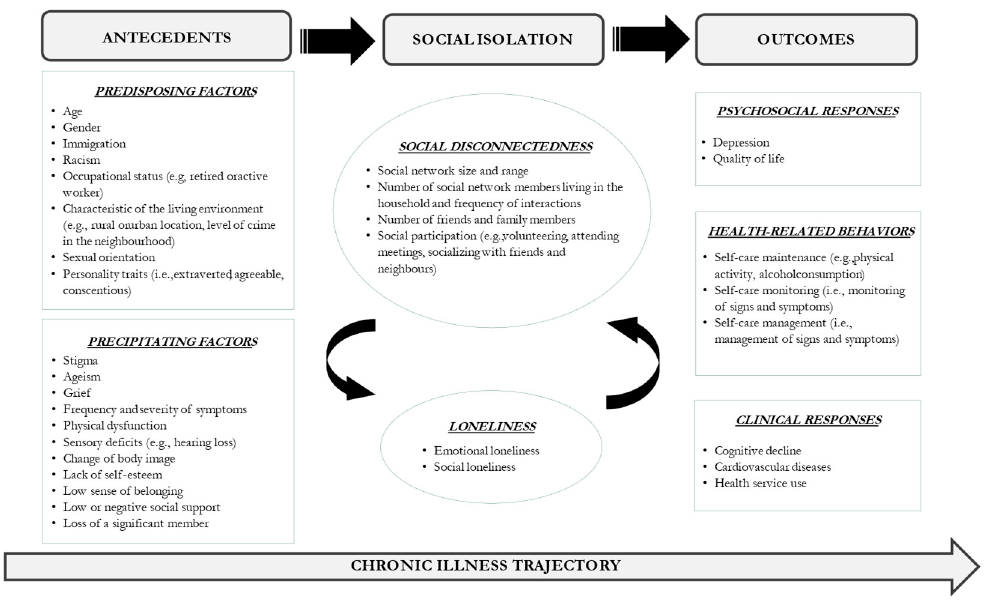
Figure 1. Pictorial model of the middle-range theory of social isolation in chronic illness.